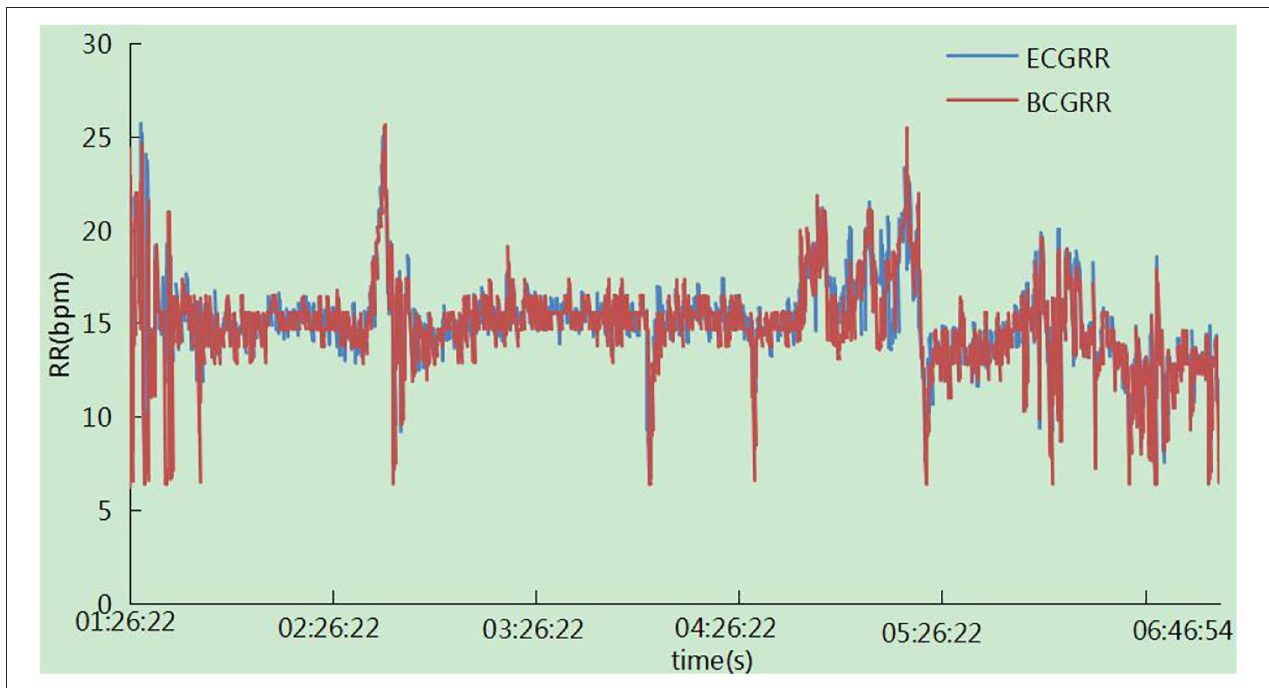
FIGURE 16 | Represents the respiration rate measurement of our system in one night.